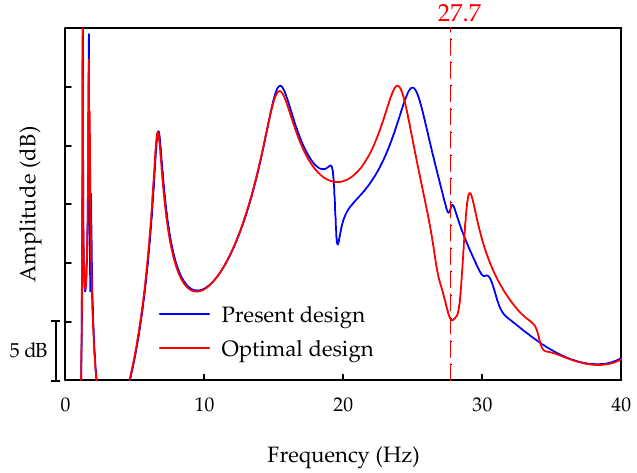
Figure 22. Comparison of the frequency response functions for the dynamic models with the present and optimal designs.